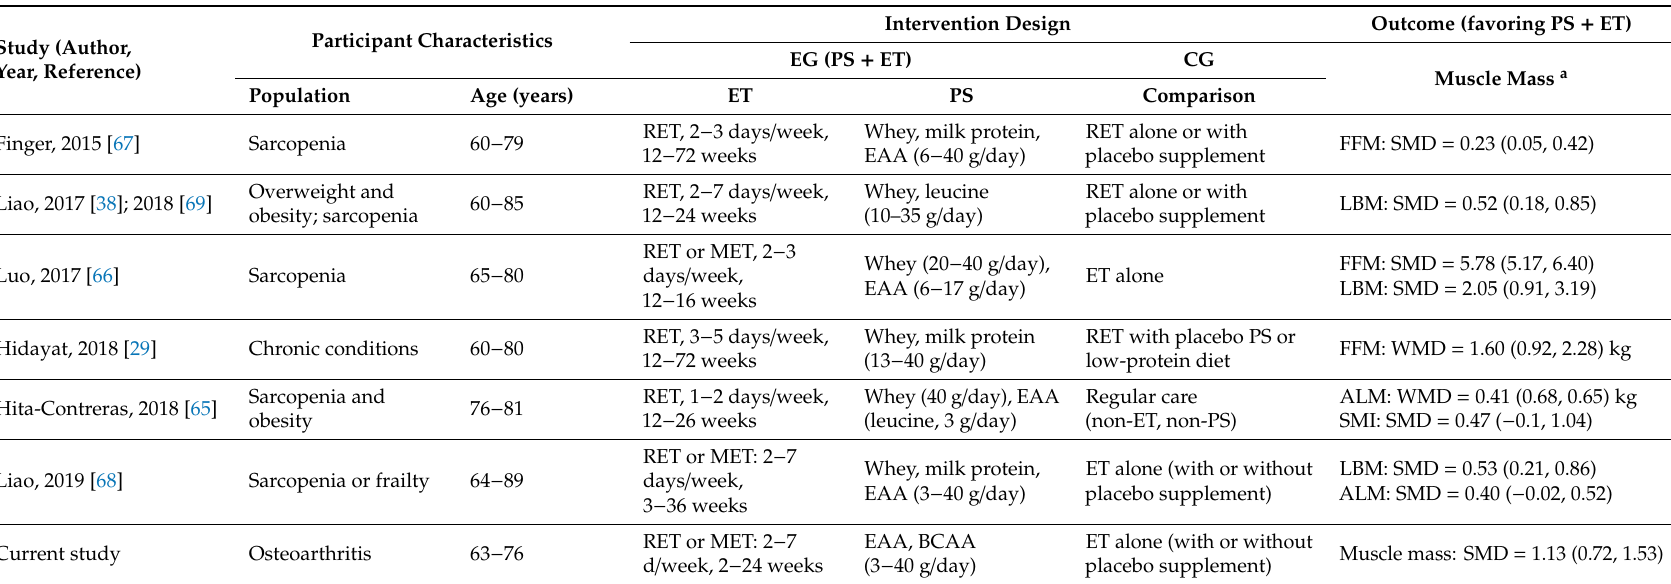
Table 2. Meta-analysis results for e ff ects of protein supplementation plus exercise on muscle mass in older